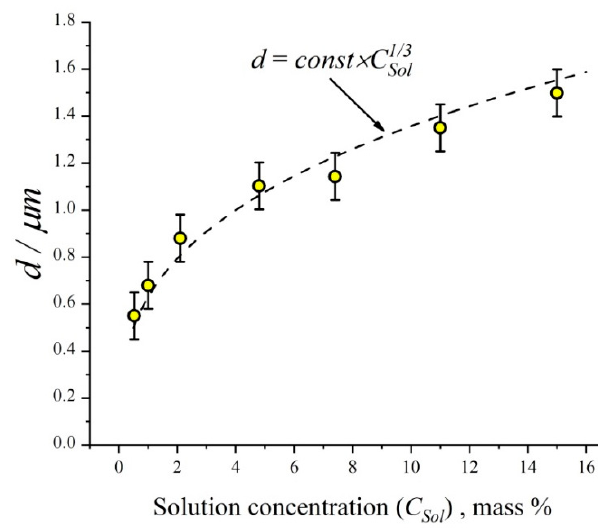
Figure 4. Particle arithmetic mean diameter as a function of ceftriaxone solution concentration in nebulizer. The dashed line follows the equation d = const × C 1/3 , where C Sol is the mass concentration of ceftriaxone in the solution.